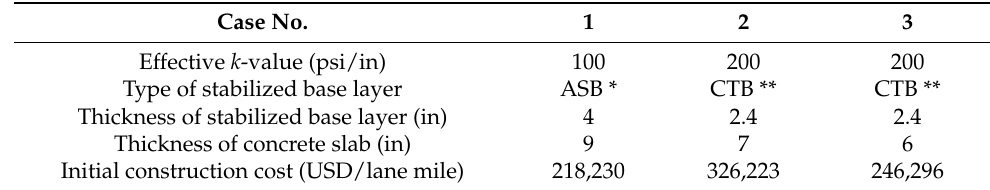
Table 15. Optimized layer compositions and initial construction costs of a CRCP structure for three cases of traffic volumes (1 in = 25.4 mm, 1 psi/in = 271 kN/m 3 ). Case No. 1 2 3 Effective k -value (psi/in) 100 200 200 Type of stabilized base layer ASB * CTB ** CTB ** Thickness of stabilized base layer (in) 4 2.4 2.4 Thickness of concrete slab